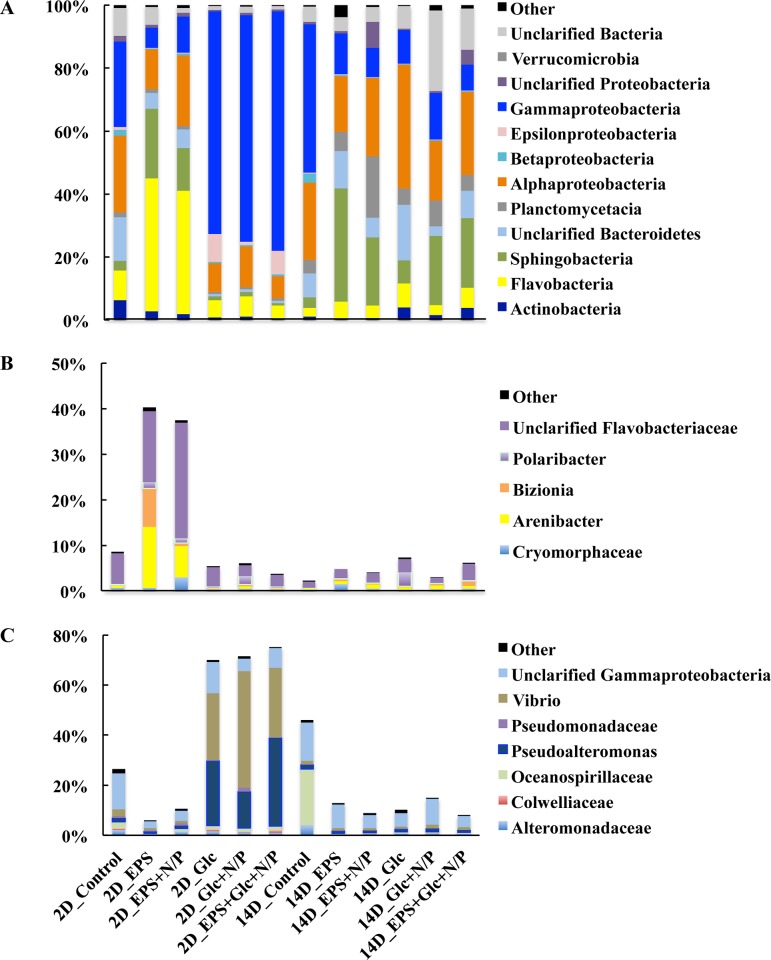
Bacterial community composition analysis.Phylogenetic compositions of the bacteria in the 2-d (2D) and 14-d (14D) cultures were analyzed. The relative abundance of each class is expressed as the mean percentage of total sequences obtained in the treatment. The major classes (A) and genus belonging to Flavobacteria class (B) and Gammaproteobacteria class (C) were indicated.